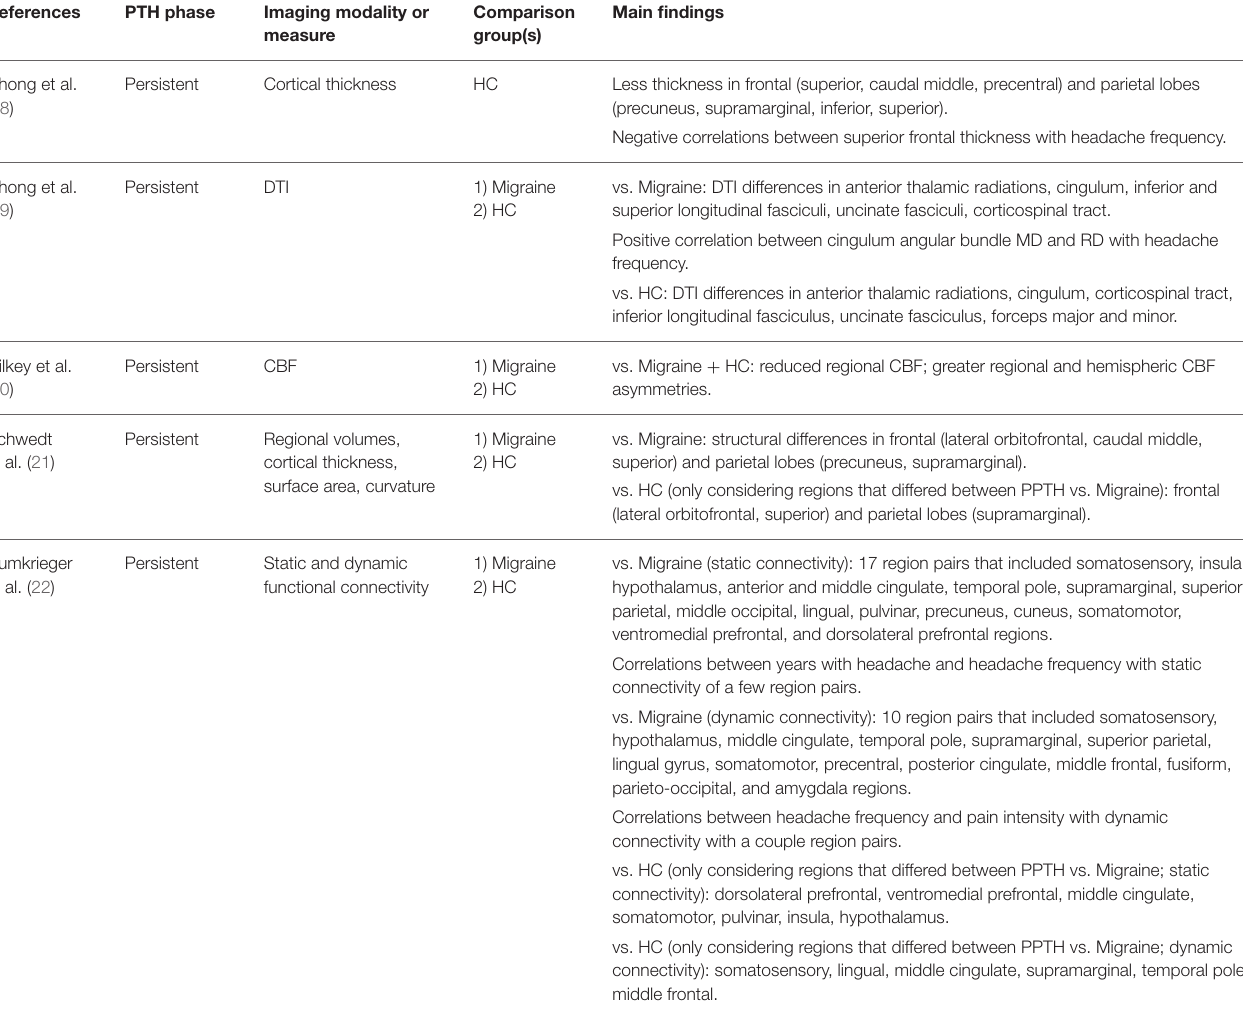
TABLE 3 | Imaging findings during persistent post-traumatic